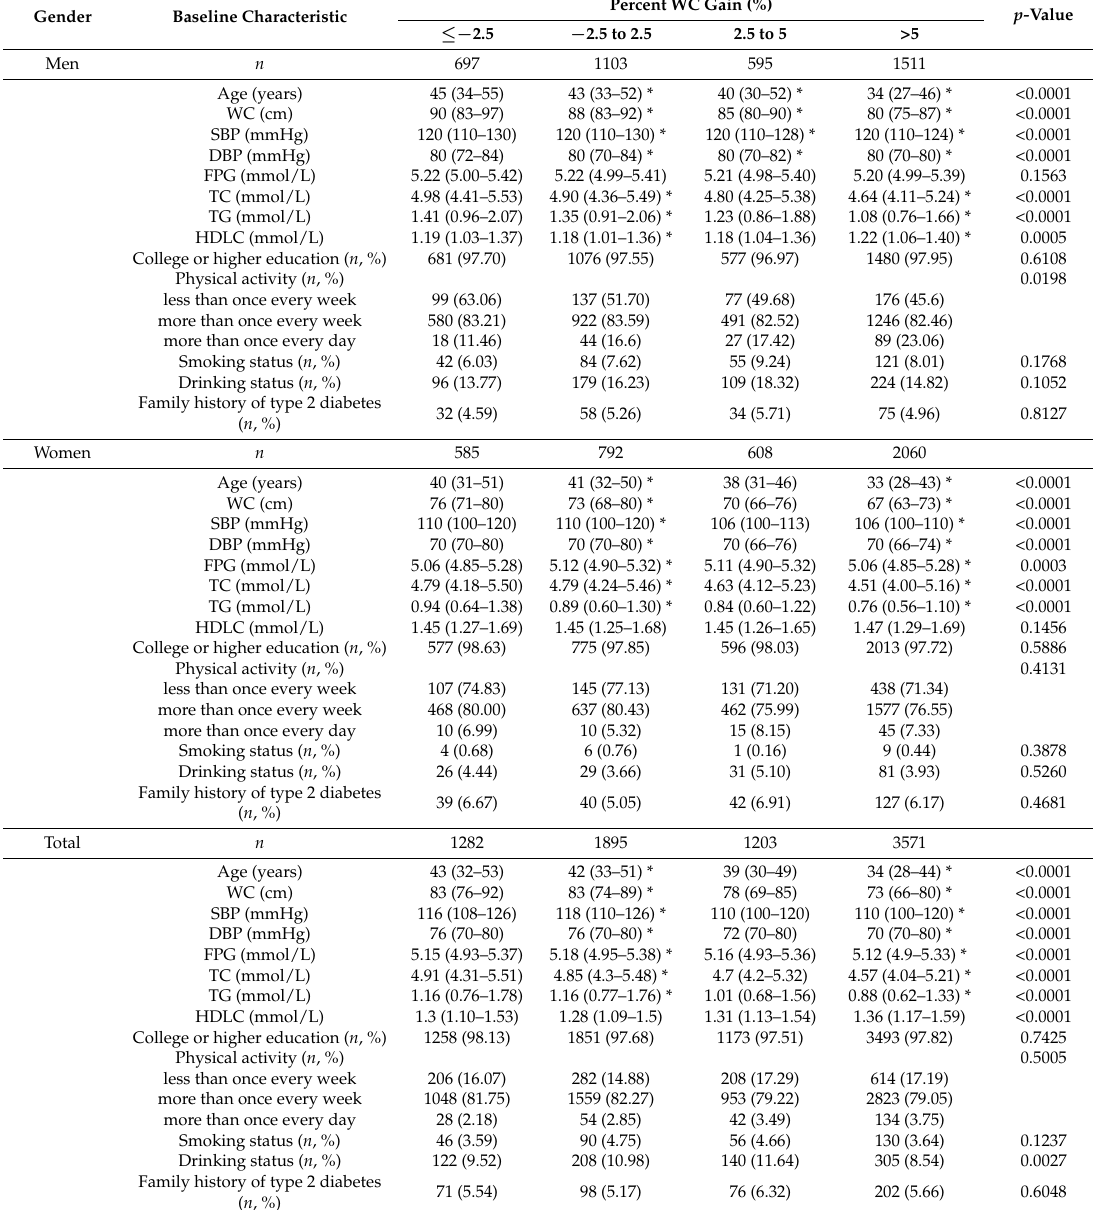
Table 1. Baseline characteristics of study participants stratified by percent waist circumference (WC)